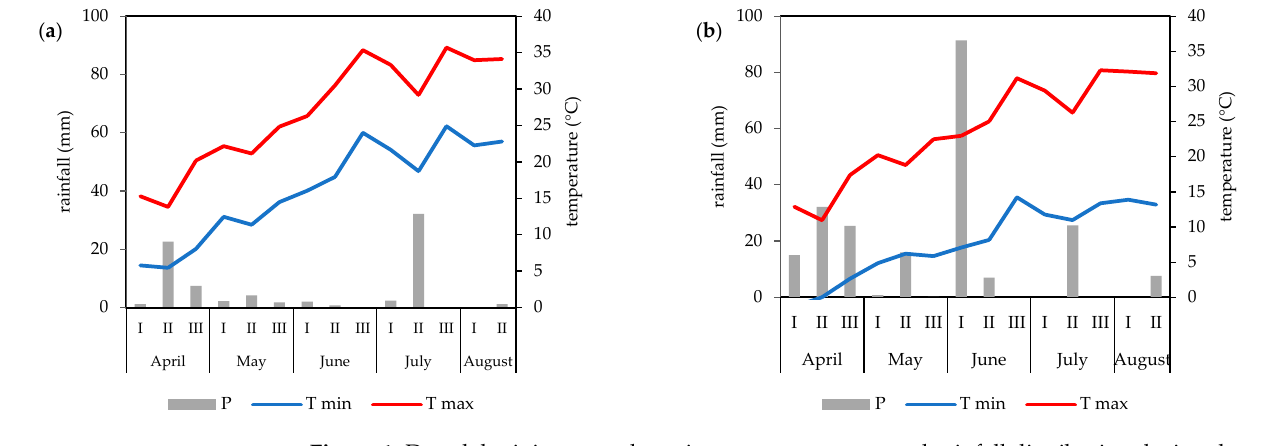
Abbreviations are as follows: E = environment; SRAD = solar radiation. Table 2. Soil physical and chemical characteristics in the investigated Table 1. Climatic information, expressed as mean and standard deviation, from long-term data (1984–2020) of the field experiments.